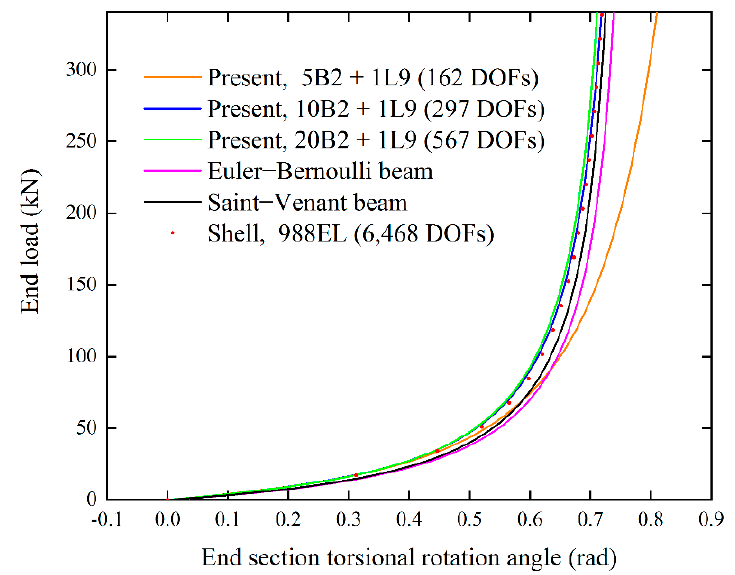
Figure 7. End section torsional rotation of a pre-twisted cantilever with rectangular cross